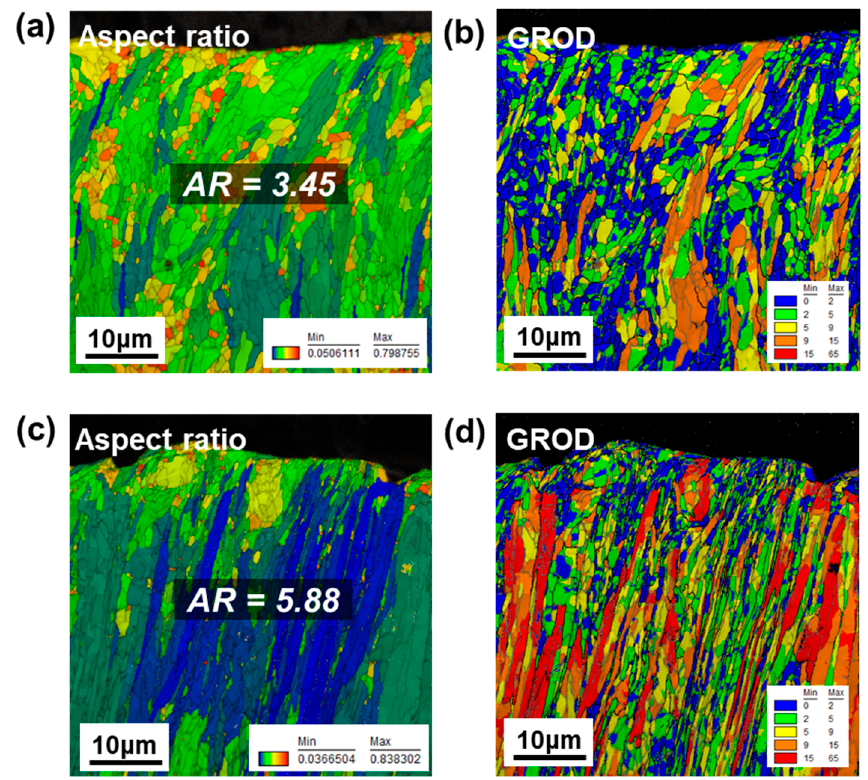
Figure 7. The grain aspect ratio and GROD maps of deformed DF-W sample: ( a , b ) static (1.3 × 10 − 4 s − 1 ); ( c , d ) high-strain-rate (5.3 × 10 − 1 s − 1 ) conditions.